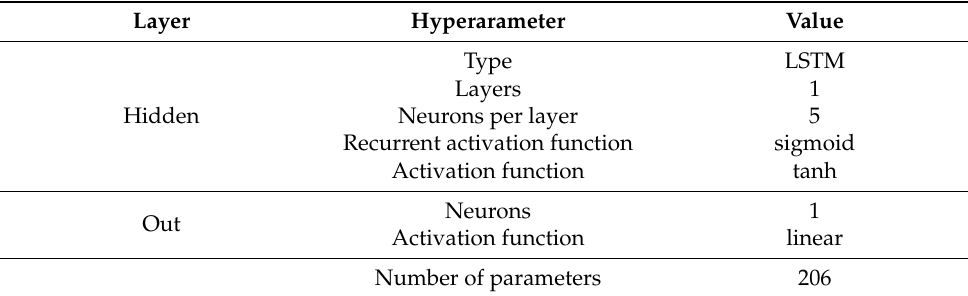
Table 1. Mirshekarian’s architecture hyperparameters